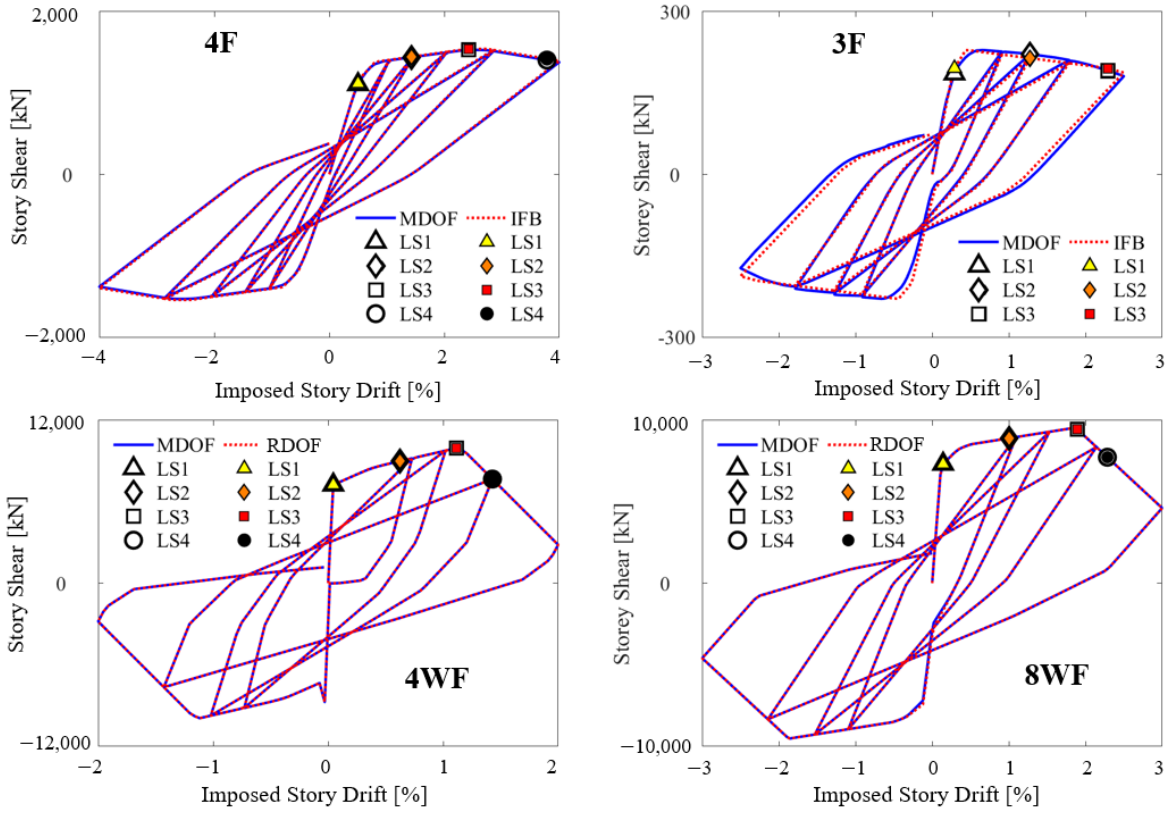
Figure 6. Storey shear – storey drift relationship based on imposed displacement analyses in first storey of IFB or RDOF models and MDOF models of 4F, 3F, 4WF, and 8WF buildings.